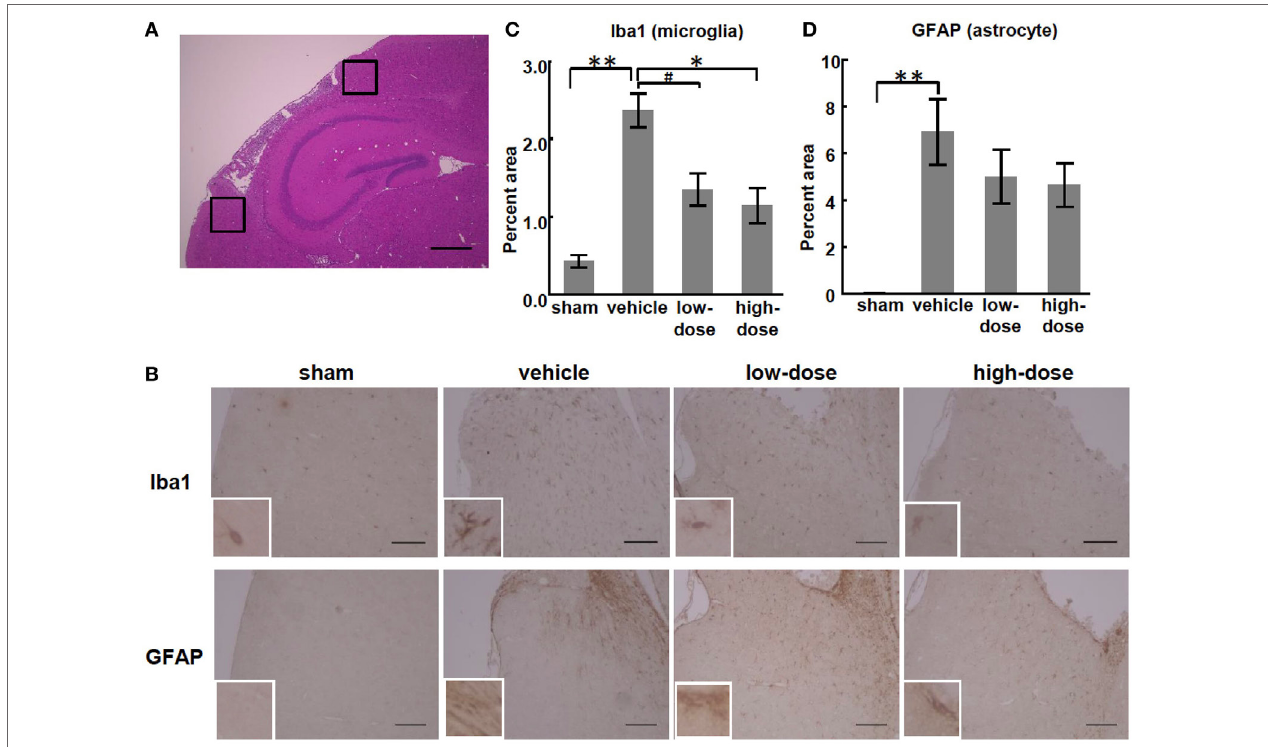
FigUre 5 | Effect of UC-MSC administration on the expression of glial cell markers in the peri-infarct cortex. (a) A representative photomicrograph of a brain coronal section stained with hematoxylin-eosin at P28. The black squares illustrate the regions that were quantified as the peri-infarct cortex. Bar, 500 µm ( × 100). (b) Representative photomicrographs of the area of the peri-infarct cortex at P28. Bar, 100 µm ( × 200). Inset shows higher magnification ( × 600). (c) The percent area of cells that stained positive for Iba1 was significantly higher in the vehicle group than in the sham group. There was a significant decrease in the high-dose UC-MSC group and a trend toward a decrease in the low-dose UC-MSC group. (D) Similarly, the percent area of cells that stained positive for glial fibrillary acidic protein (GFAP) was significantly higher in the vehicle group than in the sham group, but it was not significantly decreased in the UC-MSC groups than in the vehicle group. ** p < 0.01, * p < 0.05, and # p = 0.083.